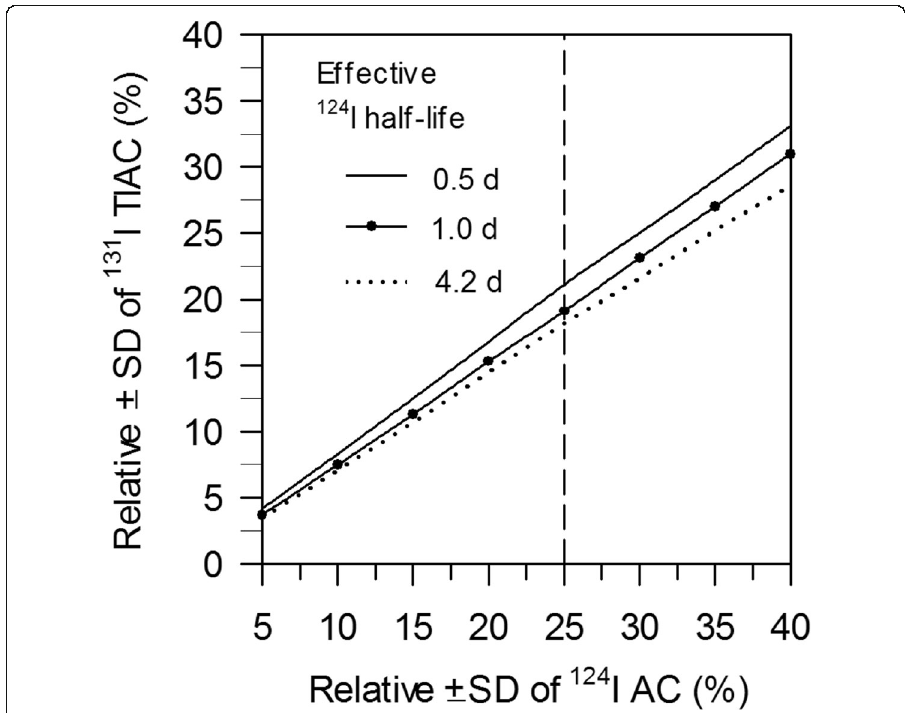
Fig. 4 Simulated relative SDs of 131 I TIAC contribution as a function of relative SD of 124 I ACs. Dashed vertical line represents the accepted relative SD of ± 25% for 124 I